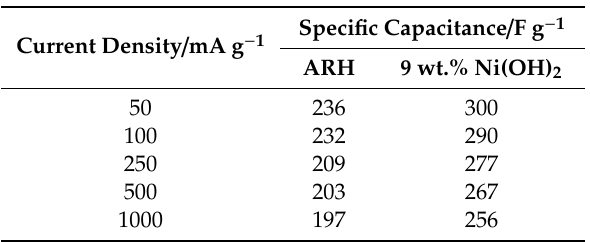
Table 2. Specific capacitance (F g − 1 ) for pure ARH electrodes and electrodes from 9 wt.% Ni(OH) 2 on ARH calculated by using the GCD